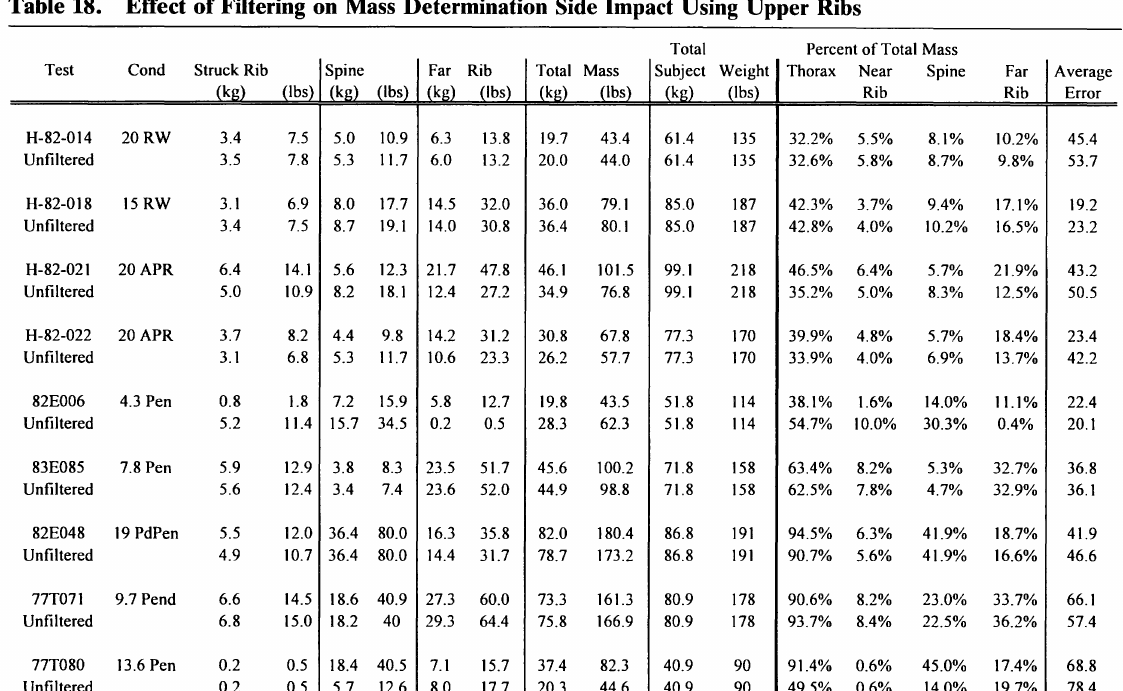
Table 18. Effect of Filtering on Mass Determination Side Impact Using Upper